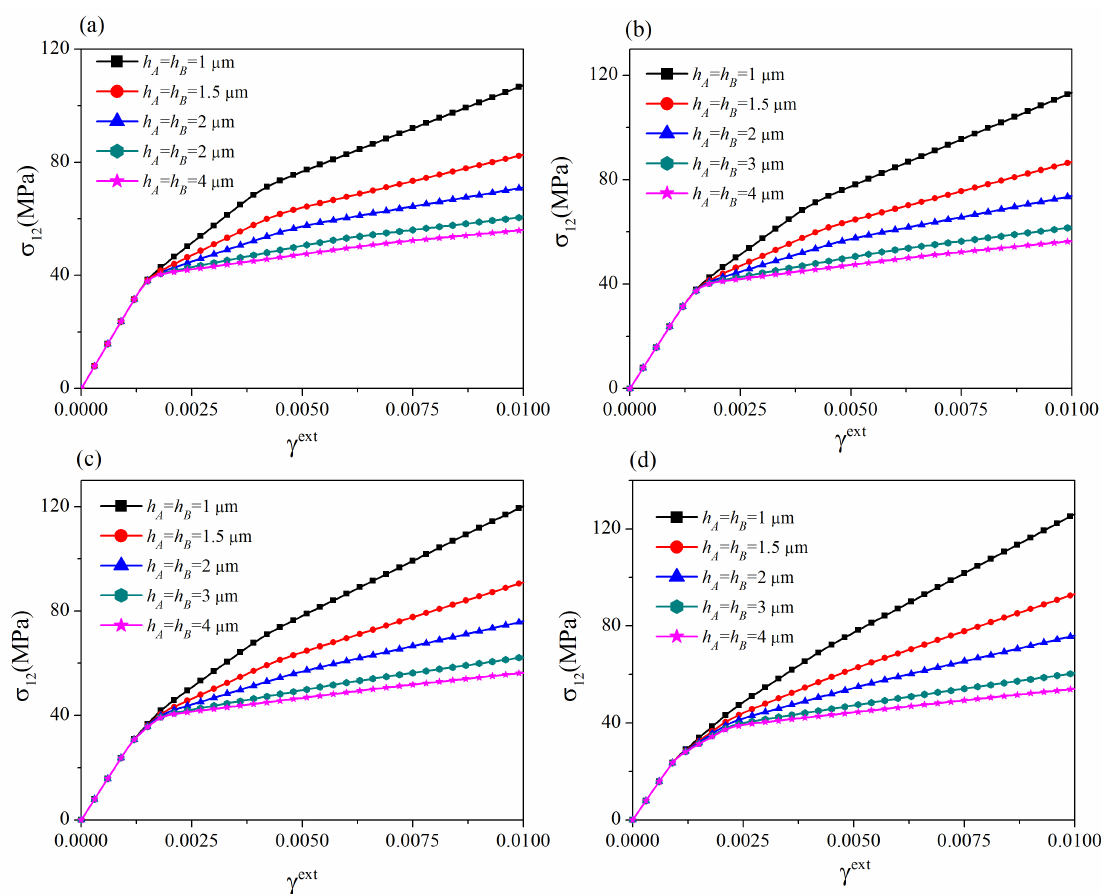
Figure 7. Size-dependent stress-strain curves: ( a ) ∆ θ = 2 ◦ ; ( b ) ∆ θ = 5 ◦ ; ( c ) ∆ θ = 10 ◦ ; ( d ) ∆ θ = 20 ◦ . For thin films with smaller grain misorientation angles, the strain hardening rate significantly decreases after the onset of slip transmission.